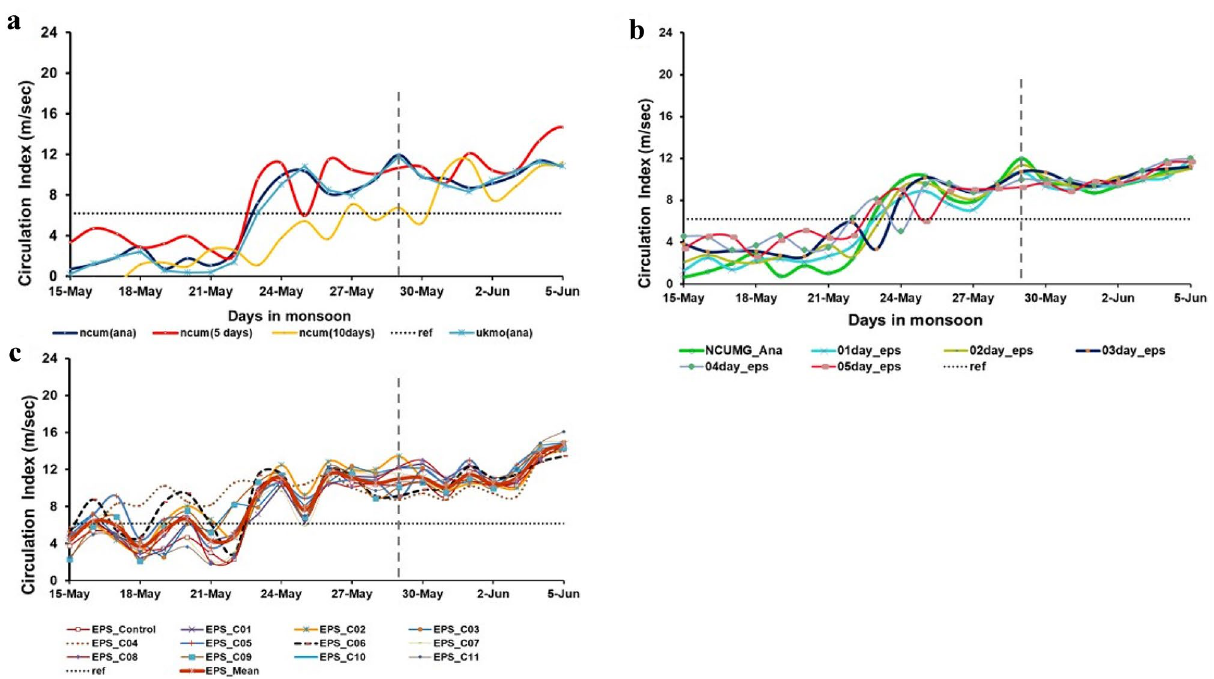
Fig. 5 Time series of daily monsoon index (m/s) during 15 May—05 June 2018 for a NCUM analysis, UKMO 5-day forecast, and NCUM 5-day and 10-day forecasts, b NEPS 1–5 days forecasts along with